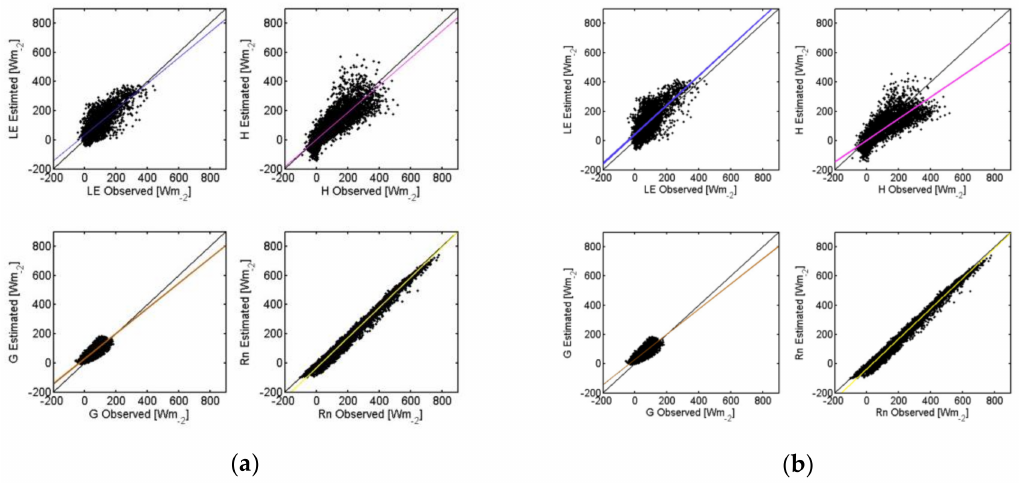
Figure 10. Estimated TSEB fluxes using TRAD vs. observed values (ECTs): ( a ) TSEB MR ; and ( b ) TSEB-G M-PT